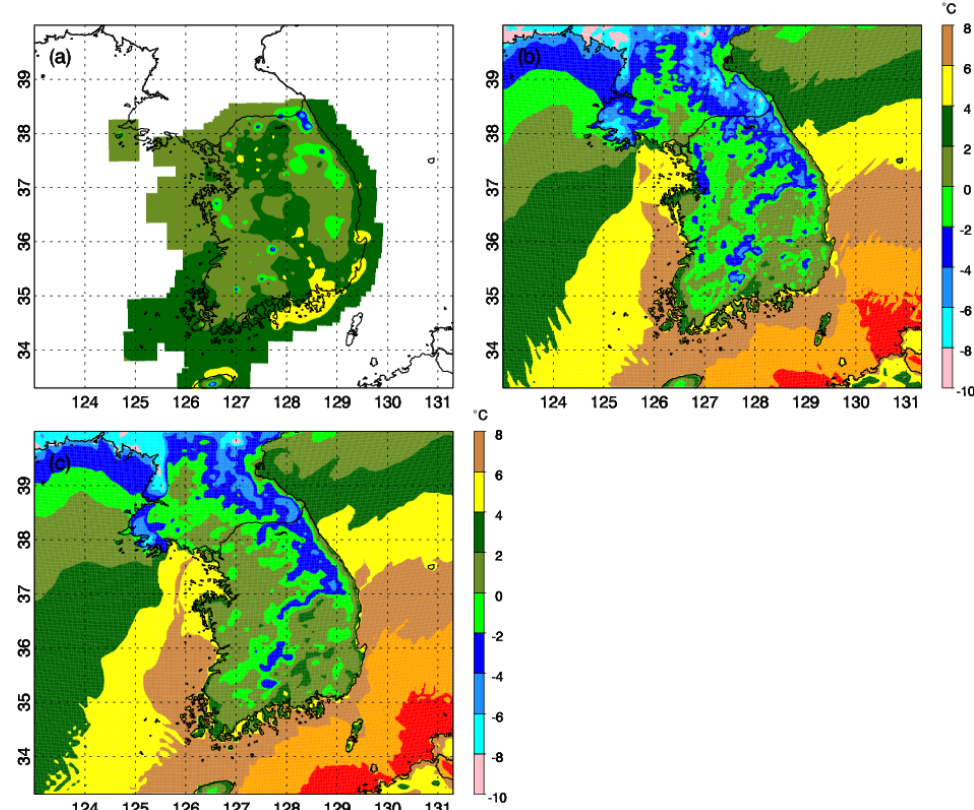
Figure 8. 2m temperature field ( ◦ C) from (a) South Korean Surface Analysis, (b) CTRL_Mar, and (c) DA_Mar at 15:00UTC 8 March